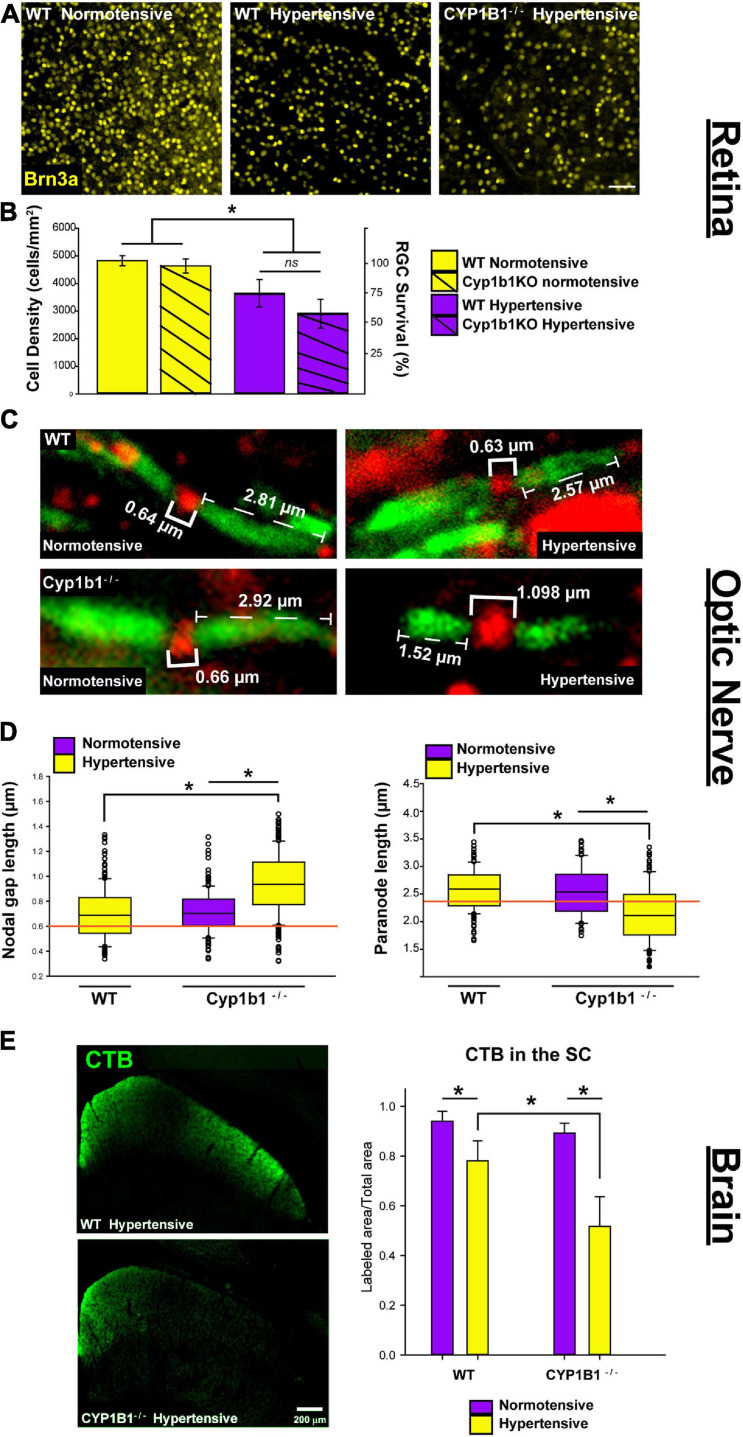
Cyp1b1–/– accelerates axonopathy in the retinal projections following ocular pressure elevation. (A) Brn3a immunofluorescence in normotensive and hypertensive flat mount retina from wildtype and Cyp1b1–/– subjects (scale bar = 50 μm). (B) Hypertensive Cyp1b1–/– (solid magenta) and wildtype (dashed magenta) retina demonstrate a significant reduction in Brn3a density compared to normotensive wildtype (solid yellow) and Cyp1b1–/– (dashed yellow) retina. Hypertensive Cyp1b1–/– demonstrate no greater loss in Brn3a density compared to hypertensive wildtype retina. (C) Longitudinal optic nerve sections immunolabeled for Nav1.6 (red) and Caspr (green) to visualize nodes of Ranvier and adjacent paranode in normotensive and hypertensive Cyp1b1–/– and wildtype optic nerves. Brackets indicate node and paranode length in microns. (D) Node lengths increased (left) while paranode lengths decreased (right) in hypertensive (yellow) Cyp1b1–/– optic nerves following 5-week elevation in IOP compared to normotensive (magenta) nerves corresponding to the saline injected eye in the same animal. Nodes and paranode lengths associated with the hypertensive wildtype optic nerves were comparable to wildtype naïve (orange line; indicates average) and normotensive Cyp1b1–/– (magenta) lengths. (E) Epifluorescent images contrasting CTB label in unilateral coronal sections through the superior colliculus of hypertensive Cyp1b1–/– and wildtype subjects. Superior colliculi corresponding to hypertensive eyes (yellow) in both Cyp1b1–/– and wildtype subjects demonstrate significant deficits in axonal transport evidenced by reduced CTB labels compared to colliculi corresponding to the saline injected normotensive eye (magenta). Collicular CTB drop-out was more pronounced in Cyp1b1–/– subjects compared to wildtypes following equivalent period of IOP elevation. Asterisk denotes statistical significance (p < 0.01).